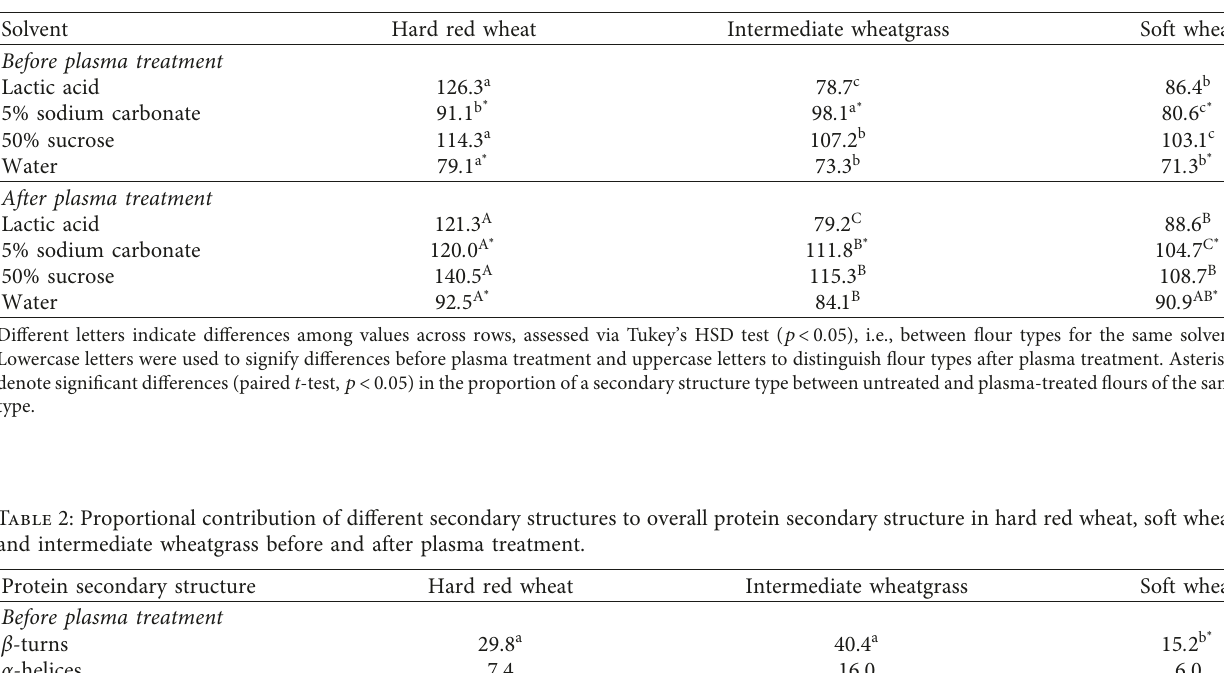
Table 1: Solvent retention capacity of flour types before and after plasma